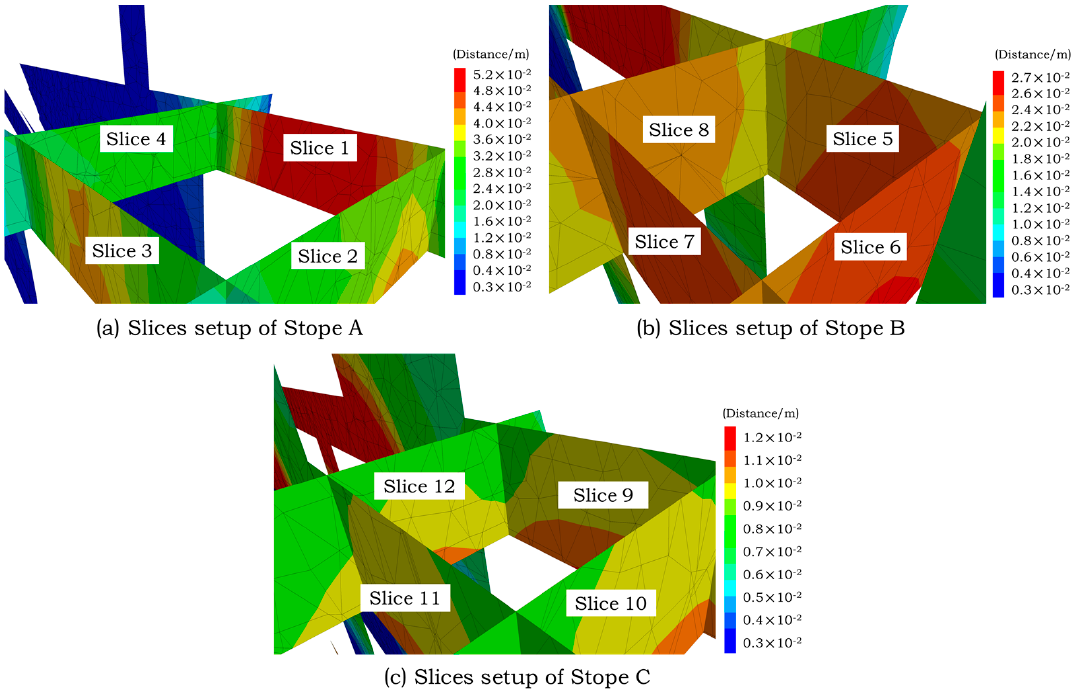
Figure 4. The 2D slices of excavated stopes (A/B/C) in the subsidence areas. Slice 1, Slice 3, Slice 5, Slice 7, Slice 9 and Slice 11 were cut along the x ­ axis to monitor the displacement and stress in the z ­ direction of the top plate, and the displacement and stress in the x ­ direction of the left ­ and right ­ hand side walls, respectively. Eight monitor ­ ing points were set.